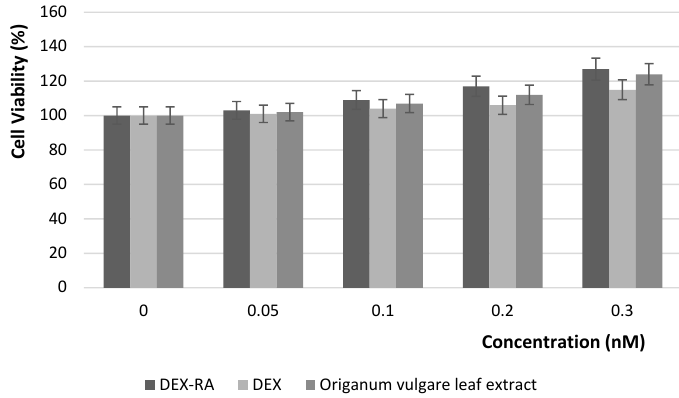
Figure 4. Effect of Dex-RA, DEX and Origanum vulgare leaf extract on keratinocytes viability.